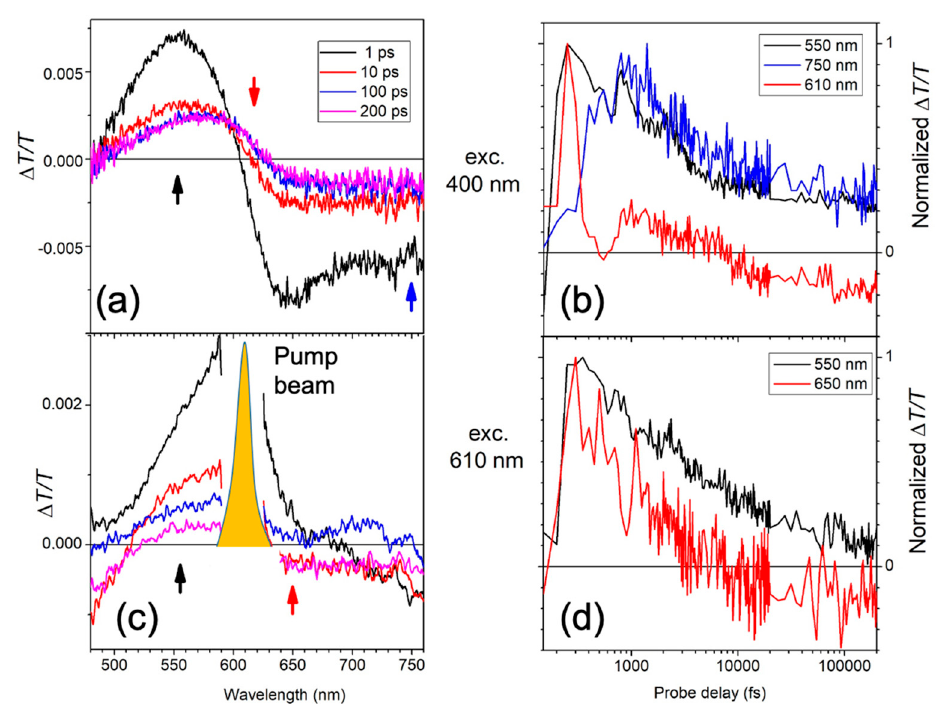
Figure 2. Left panel: Transient absorption spectra at different probe delays for the continuous polymer film at the different wavelengths of pump excitation: 400 nm ( a ) and 610 nm ( b ). The arrows correspond to different wavelengths (black, 550; red, 650; and blue 750 nm) at which the temporal decays are shown in ( b , d ). Right panel: Time decays at the two different pump excitation wavelengths: ( b ) 400 and ( d ) 610 nm. The shape of the 610 nm pump beam is also shown in ( c ).